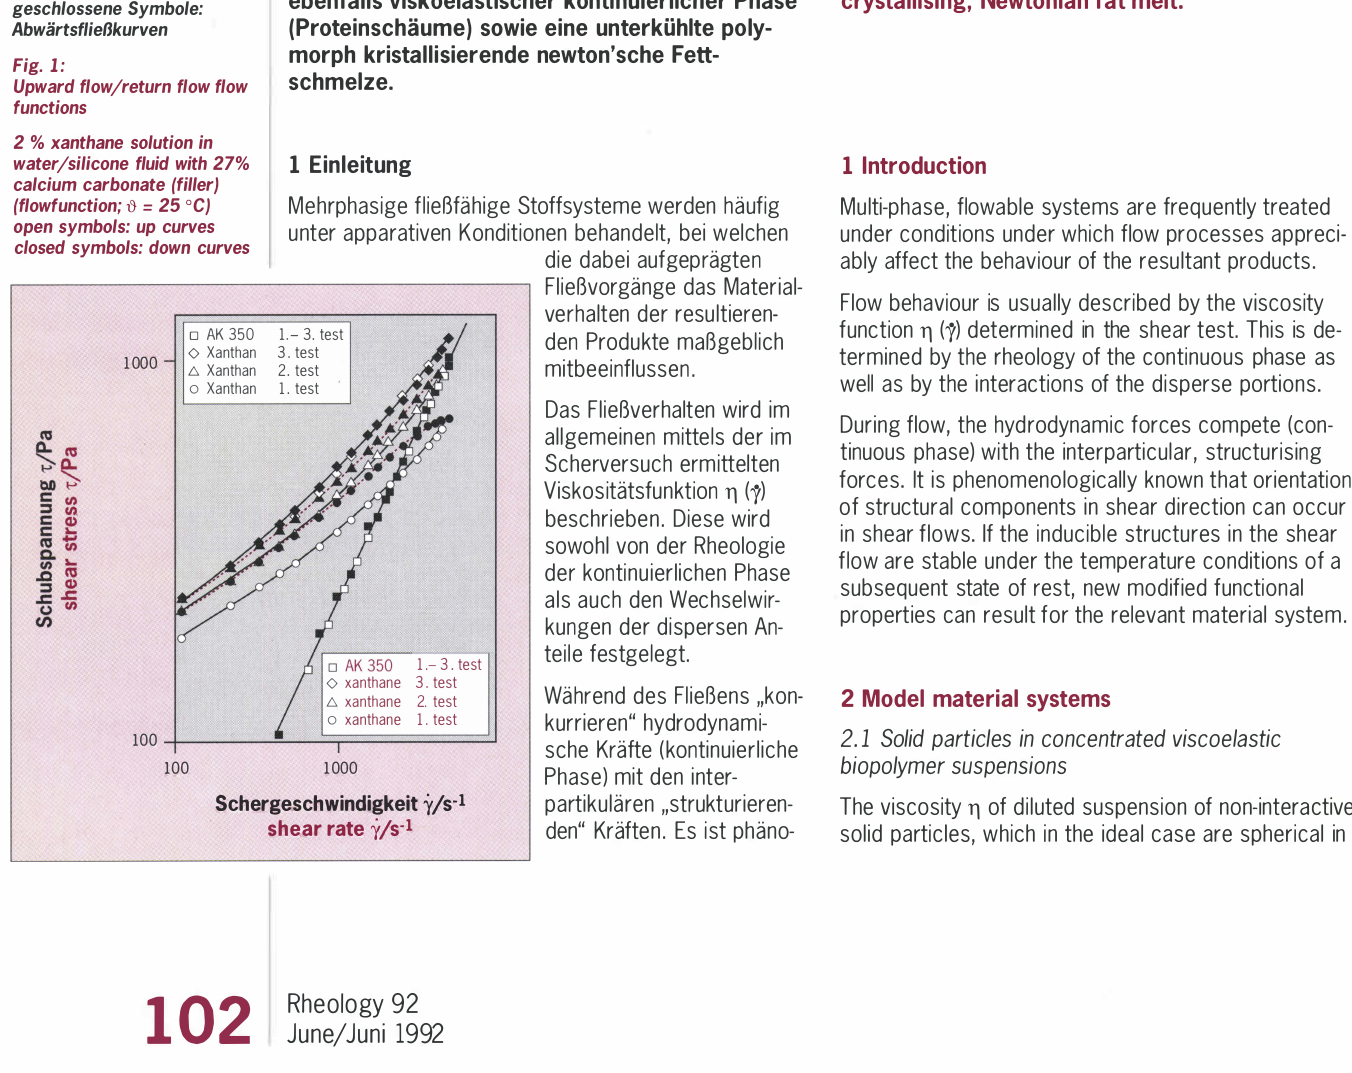
offene Symbole: AufwiirtsflieOkurven geschlossene Symbole: AbwiirtsflieOkurven Fig. 1: Upward flow/return flow flow functions